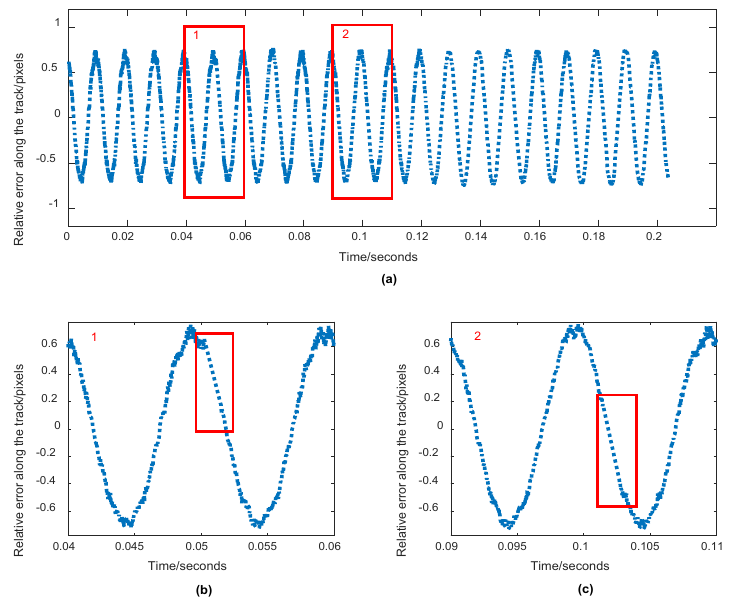
Figure 11. The 100-Hz jitter detection curves by sequential disparity maps after interpolation. ( a ): The whole detected results after interpolation; ( b ): the local amplification of rectangular area 1 in ( a ); ( c ): the local amplification of rectangular area 2 in ( a ).